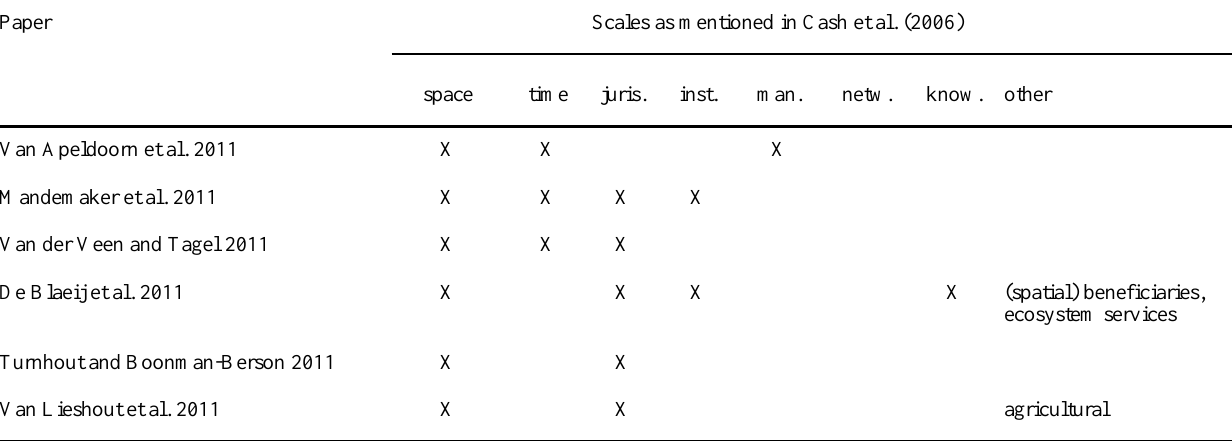
Table 1. Scales as mentioned in Cash et al. (2006) and their occurrence in the six case study papers. Paper Scales as mentioned in Cash et al. (2006) space time juris. inst. man.